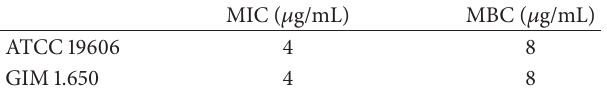
Table 1: Minimal inhibition concentration (MIC) and minimum bactericidal concentration (MBC) of Mdc. MIC ( 𝜇 g/mL) MBC ( 𝜇 g/mL) ATCC 19606 4 8 GIM 1.650 4 8